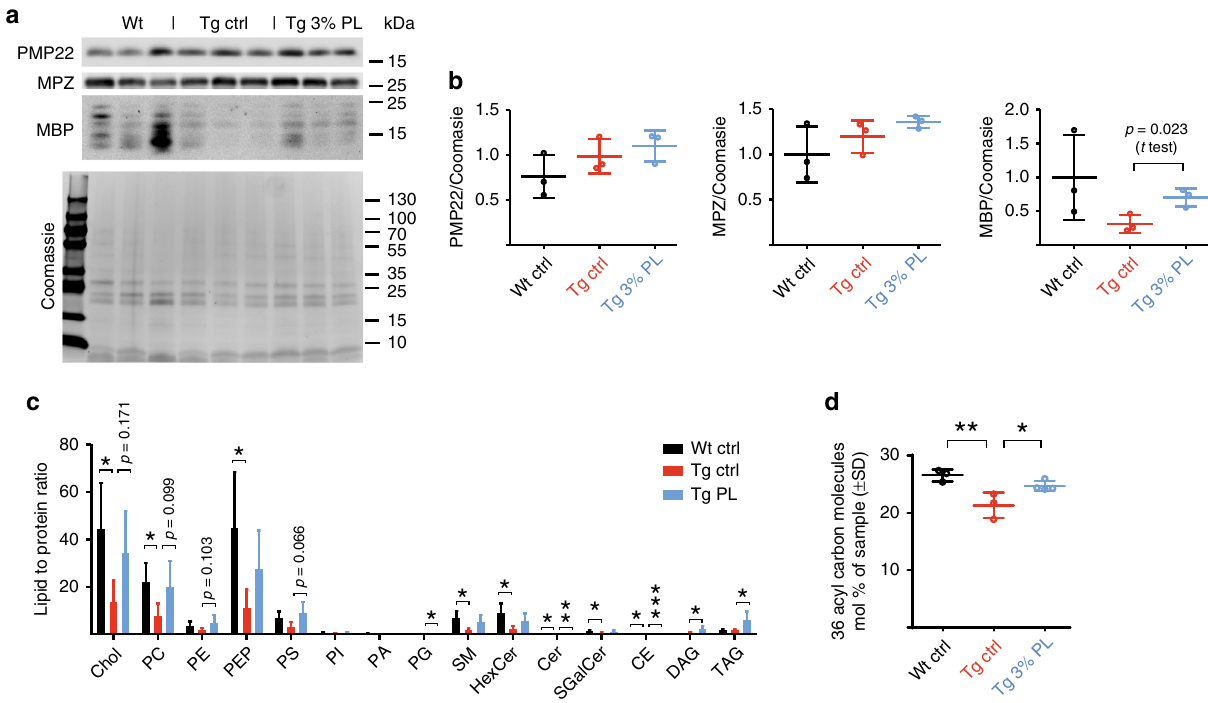
Fig. 5 Phospholipid therapy in CMT rats improves myelin composition. a Western blot analysis of PMP22, MBP, and MPZ from puri fi ed P112 sciatic nerve myelin from Wt, Tg ctrl, and Tg 3% PL rats aged 112 days. As loading control, a Coomassie staining of the gel was performed ( n = 3 per group). Shown is the Coomassie gel for the PMP22 and MBP blot. MPZ was analyzed on a second blot. b Quanti fi cation of a shows an increased PMP22/MBP ratio in the myelin of Tg compared with Wt controls (left panel, one-way ANOVA). In non-treated (Tg ctrl) versus treated (Tg 3%PL) CMT rats, no quantitative difference of PMP22 in myelin could be detected when normalized to Coomassie (middle panel), whereas more MBP could be detected in the treated group (right panel, Student ’ s t test). c Mass spectrometric analysis of sciatic nerve myelin from Wt ctrl (black, n = 4), Tg ctrl (red, n = 3), and Tg 3% PL (blue, n = 3) rats, puri fi ed after study end (P112), shows decreased lipid-to-protein ratios for many lipid classes in the Tg ctrl rats, compared with Wt ctrl rats. PL treatment (not signi fi cantly) improved lipid-to-protein ratios in puri fi ed myelin. Chol cholesterol, PC phosphatidylcholine, PE phosphatidylethanolamine, PEP PE plasmalogens, PS phosphatidylserine, PI phosphatidylinositol, PA phosphatidic acid, PG phosphatidylglycerol, SM sphingomyelin, HexCer hexylceramide, Cer ceramide, SGalCer S-galactosylceramide, CE cerebroside, DAG diacylglycerol, TAG triacylglycerol. Non- adjusted p values are shown (one-way ANOVA). d Mass spectrometric analysis of sciatic nerve myelin from Wt ctrl (black, n = 4), Tg ctrl (red, n = 3), and Tg PL (blue, n = 3) rats, puri fi ed after study end (P112), displaying only molecules with 36 acyl carbons, which are less abundant in CMT compared with Wt rat myelin and is normalized after PL therapy, suggesting that the supplemented phospholipids (mostly comprised of C18 fatty acids, see Methods)